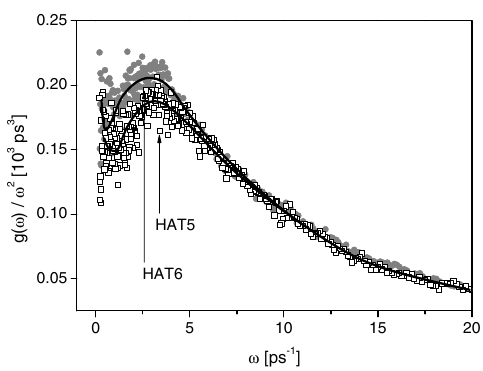
Figure 4. Temperature dependence of the effective mean square displacement < u 2 > eff for HAT6. The dotted lines correspond to the phase transition temperatures estimated by DSC. The inset enlarges the temperature dependence of < u 2 > eff up to a temperature of 300